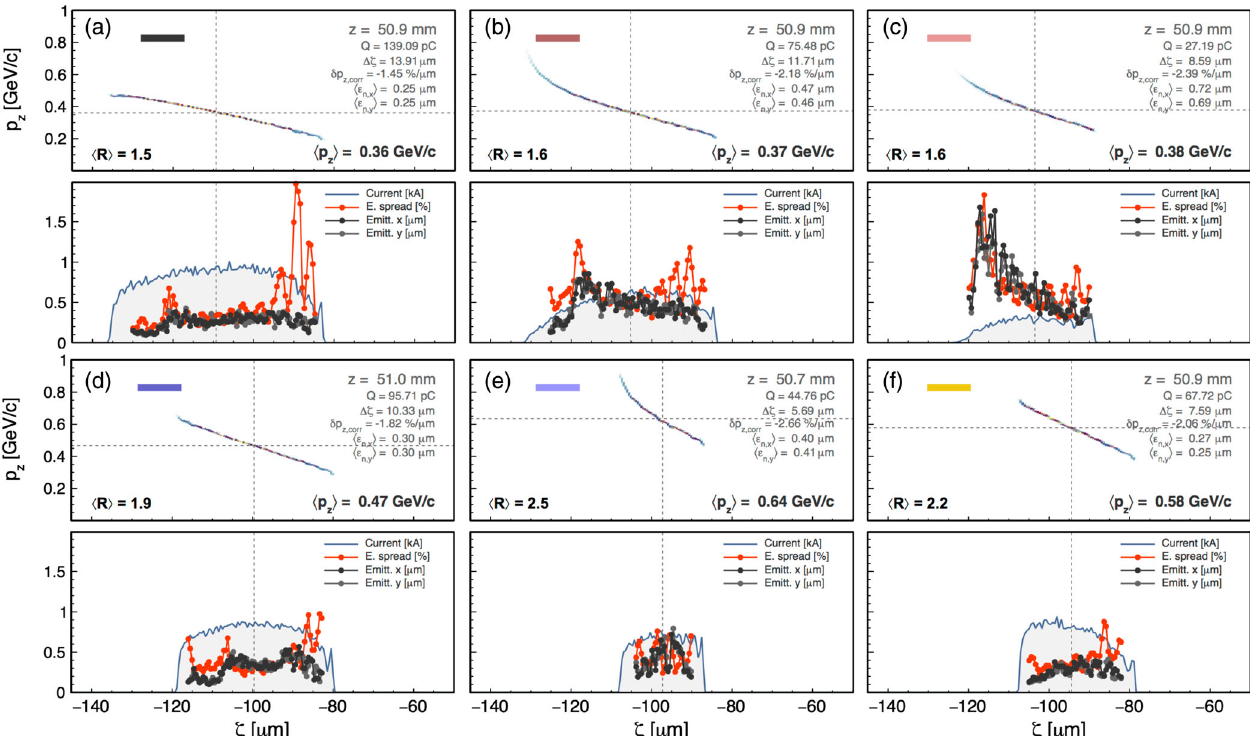
FIG. 8. (Top) Longitudinal phase-space and (bottom) sliced energy spread, normalized transverse emittance and peak current of the witness bunches after a propagation distance of ∼ 5 cm. In these simulations, only the plasma density profile is varied. See Fig. 7 for a graphical representation of the considered